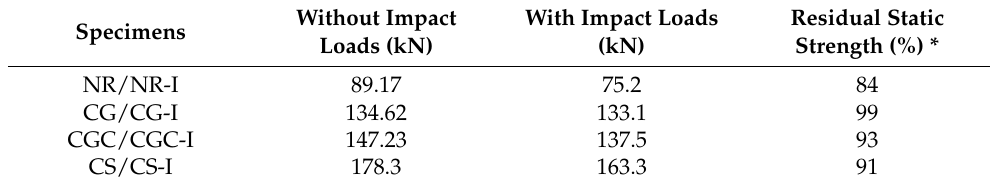
Table 7. Ultimate capacities of the specimens without and with previous impact loads.